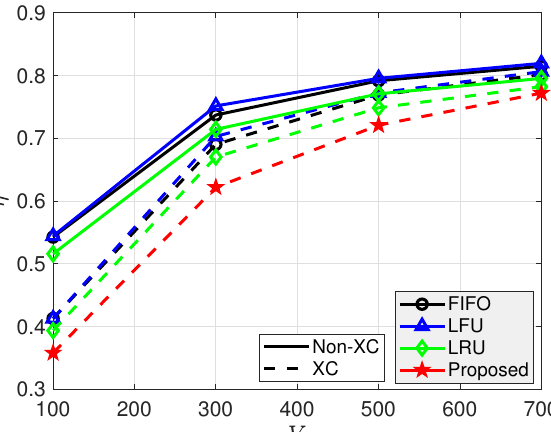
Figure 9. Average number of required transmissions for various V values. p = 0.001, ρ = 0.5, β = 1, N = 50, C = 20, and K = 10.